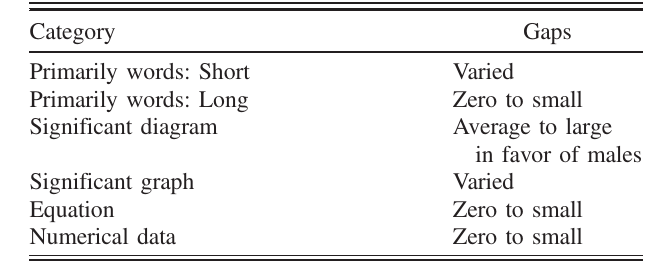
TABLE V. Pattern of gender gaps within the presentation